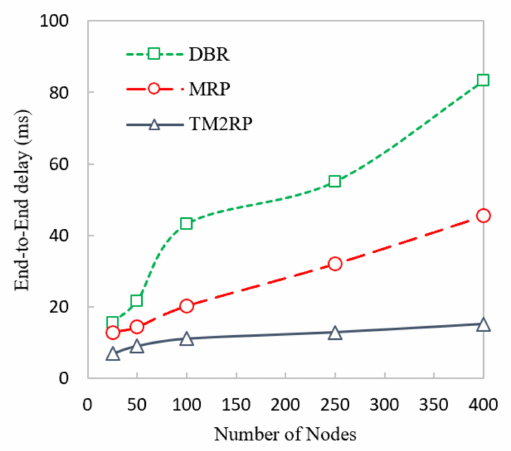
Figure 13. Comparison of underwater end-to-end delay performance with increasing number of